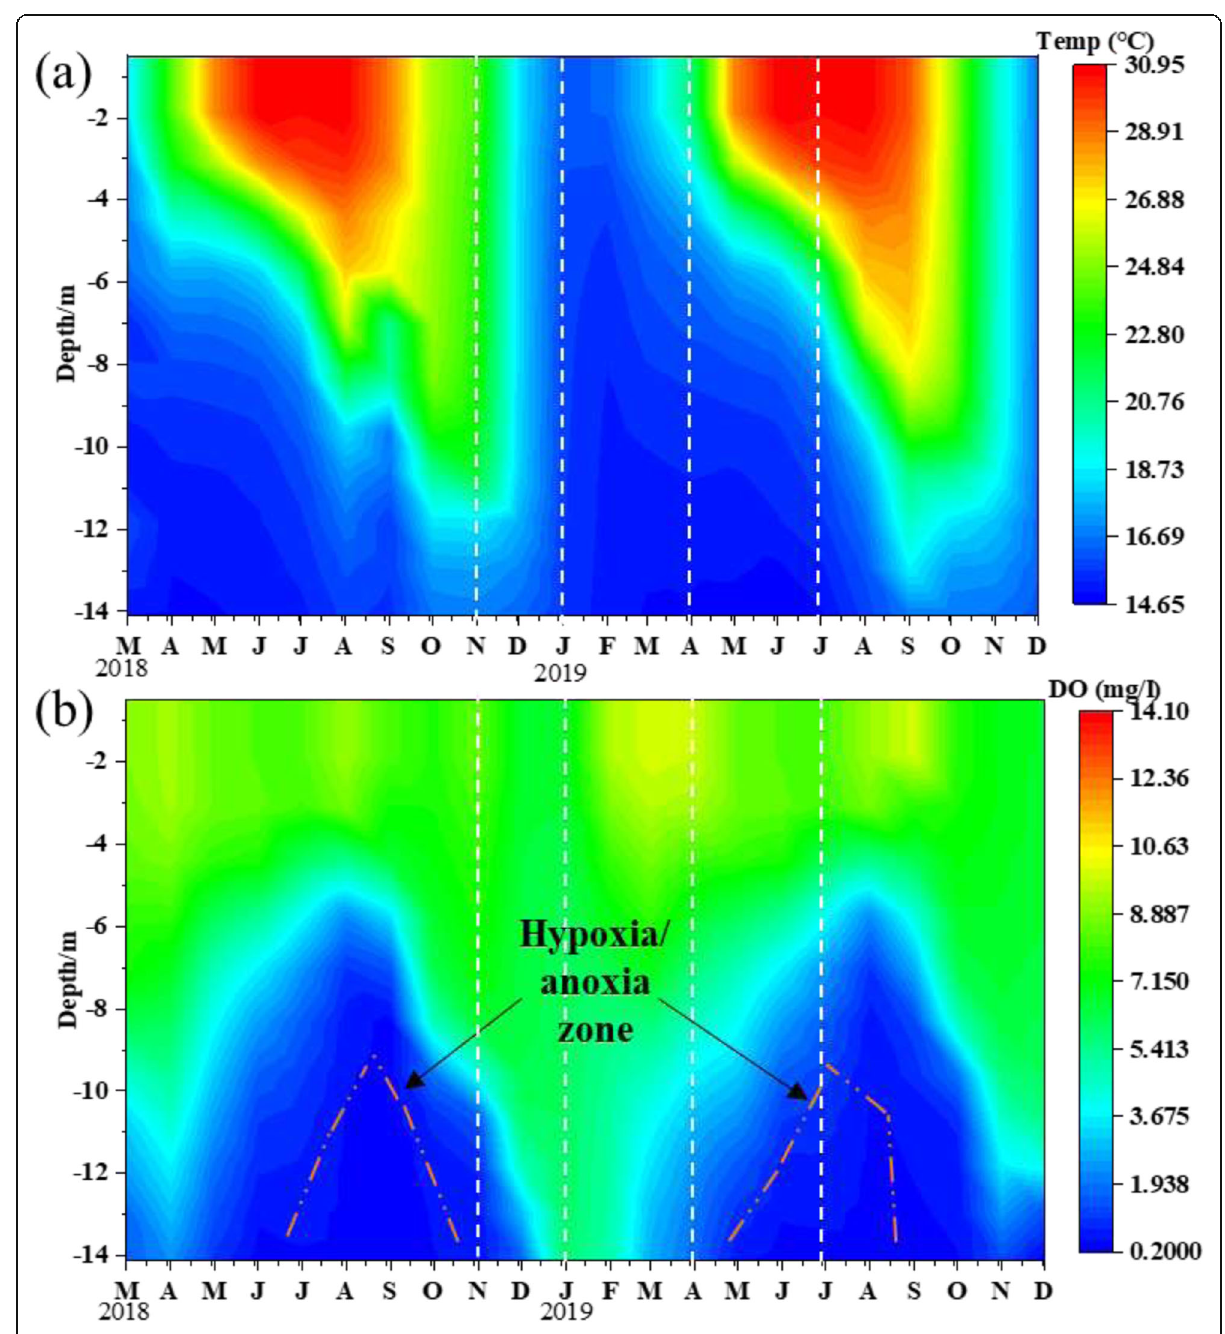
Fig. 2 Variation in depth of a water temperature and b dissolved oxygen profiles of Tianbao reservoir with time from March 2018 to December 15, 2019. Data was collected at 12:00 each day at sampling site X. Dashed vertical lines show dates of sampling (spring-April 2019,